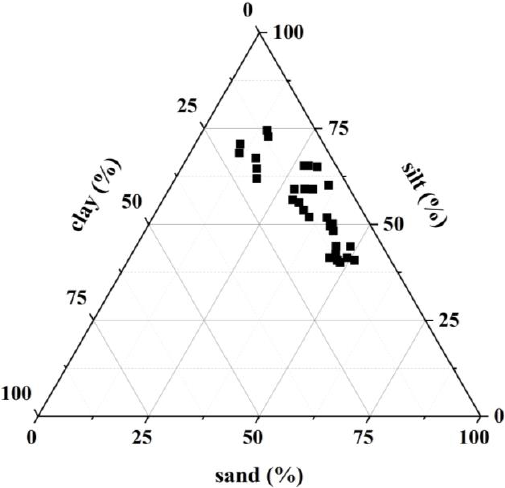
Figure 3. Ternary diagram of the wetland sediment particle-size characteristics.